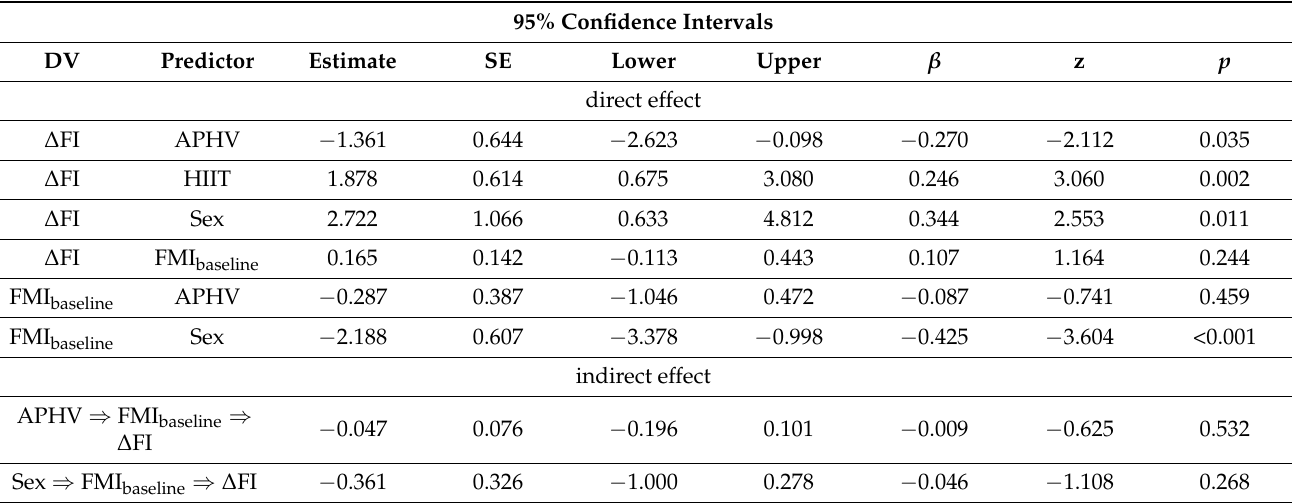
Table 2. Direct and indirect effects of APHV, HIIT, sex, preintervention FMI on ∆ FI. 95% Confidence